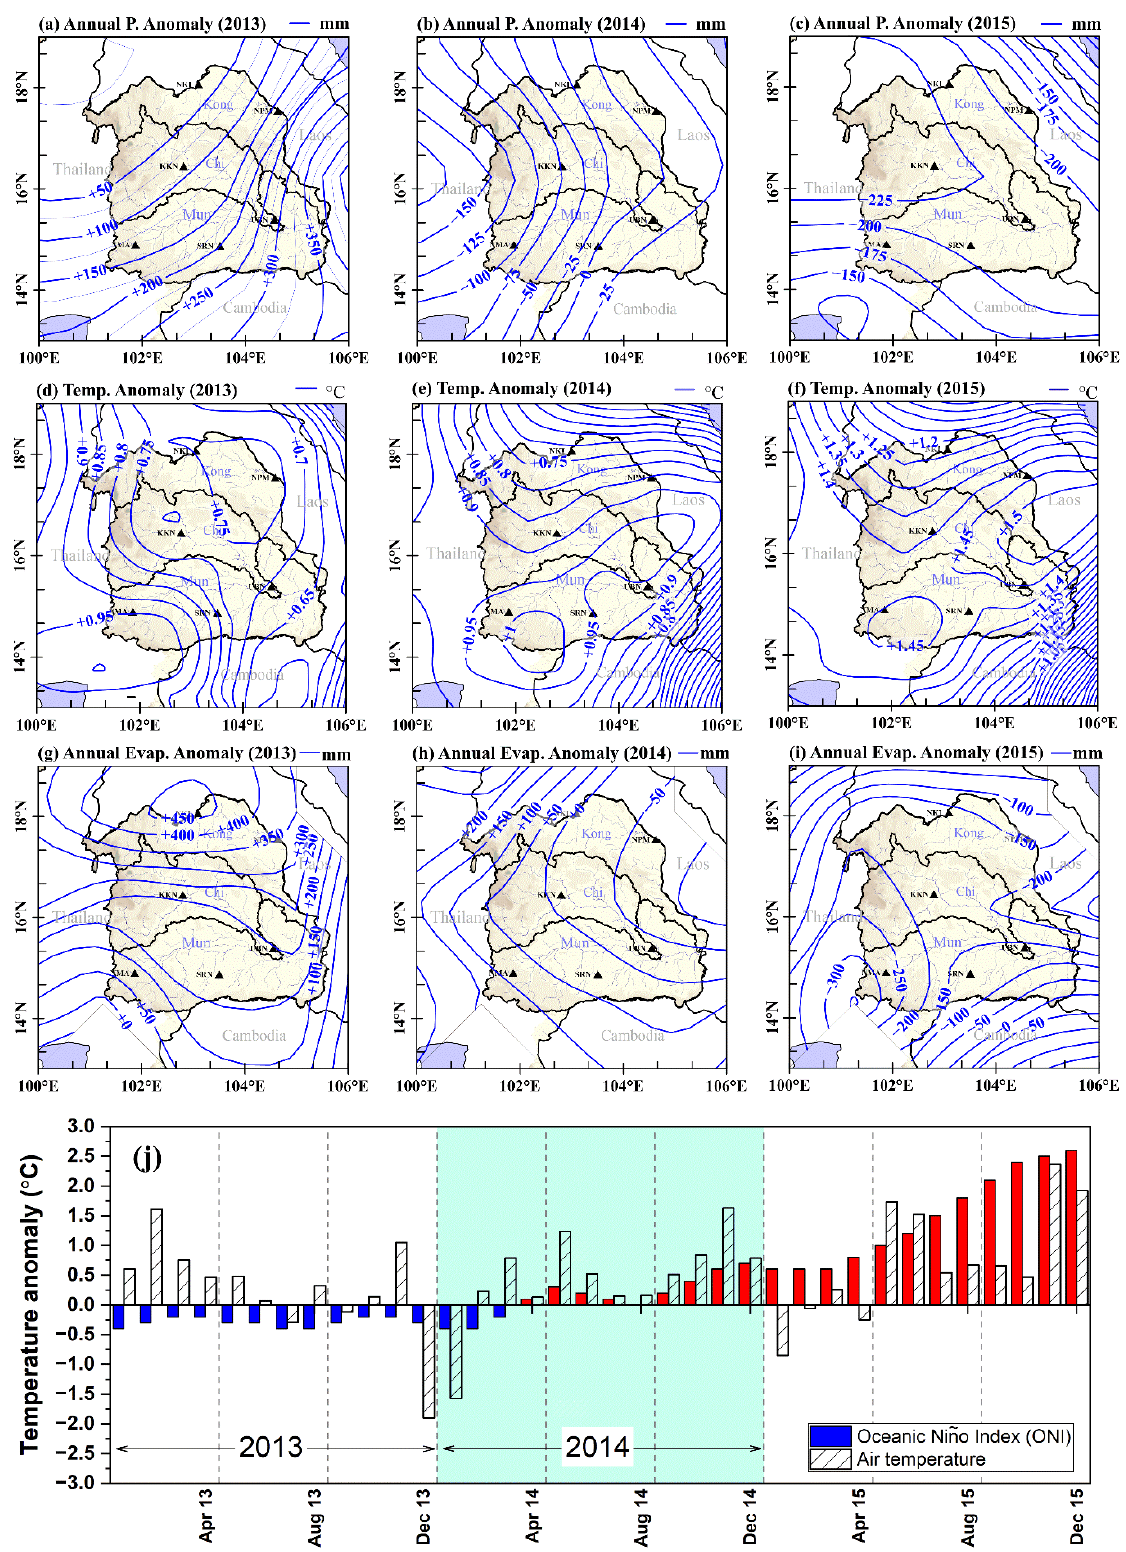
Figure 2. Climate anomalies relative to the 30-year average (1981–2010). ( a – c ) Annual precipitation anomaly (PA; mm). ( d – f ) Mean temperature anomaly (Temp.; ◦ C). ( g – i ) Annual evaporation anomaly (Evap.; mm). ( j ) Monthly Oceanic Nino Index (ONI; full bars) and the air temperature anomaly (slashed bars). Plus (+) or minus ( − ) show higher or lower than the 30-year average (1981–2010). Blue and red ONI bars in ( j ) denote La Niña and El Niño, respectively.